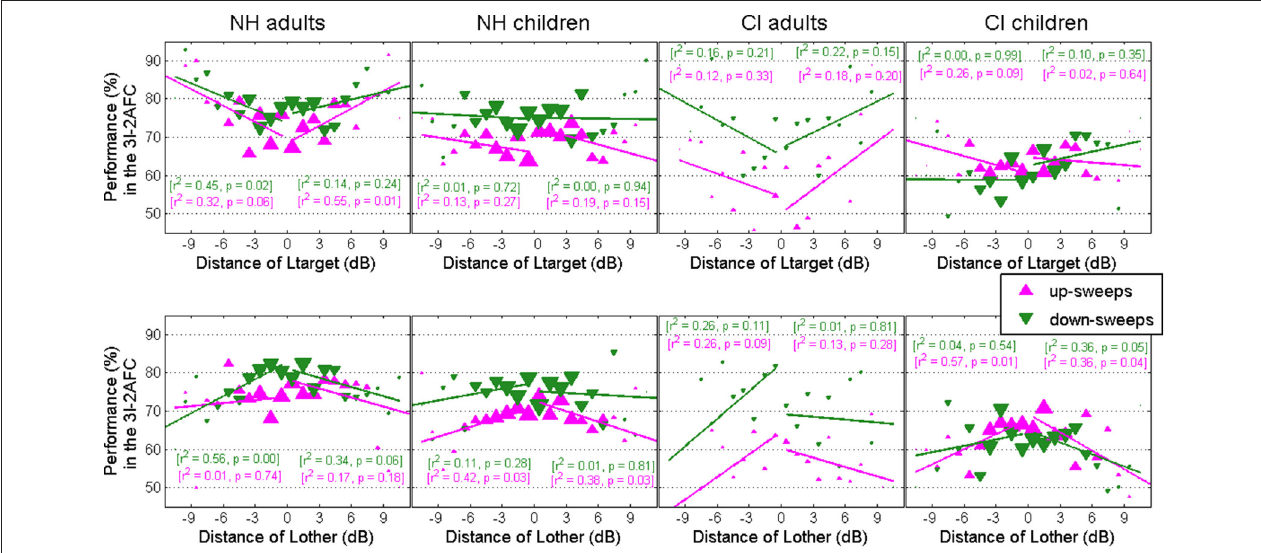
FIGURE 4 | Performance for the discrimination task only, pooled across all rates and all subjects within a population, as a function of the difference between the target level and that of the two other intervals (top) or the difference between the non-target level and that of the two other intervals